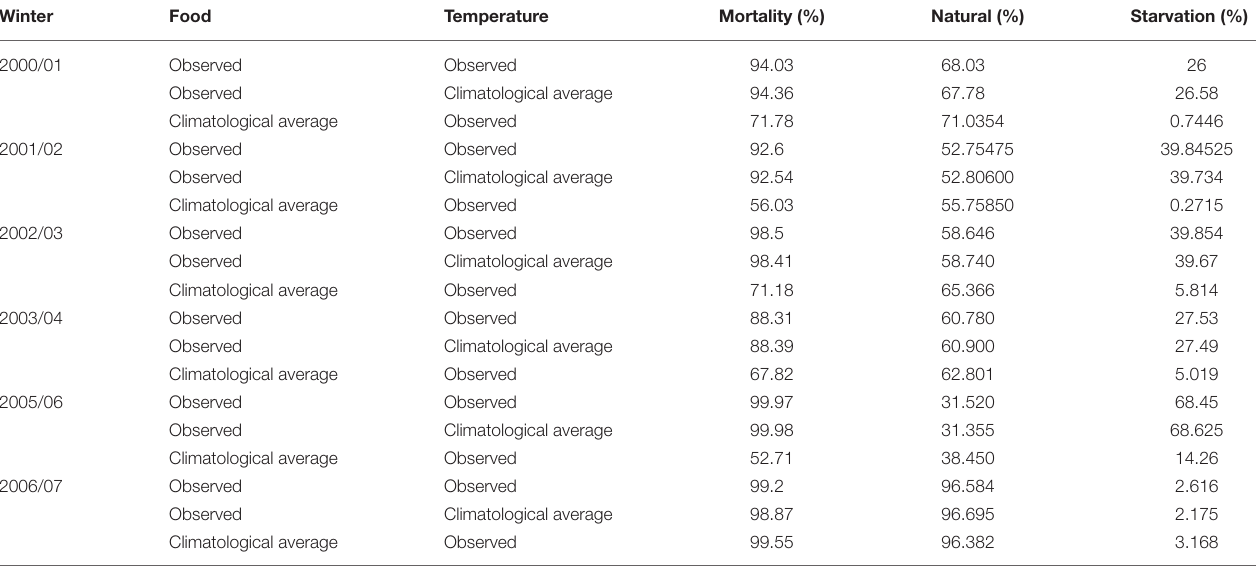
TABLE 2 | Sensitivity of modeled 0-group survivorship (%) between June and the following April to food and temperature.